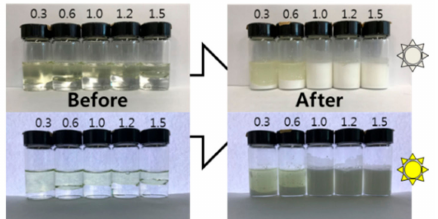
Figure 1. Emulsions viewed with and without backlighting before and after